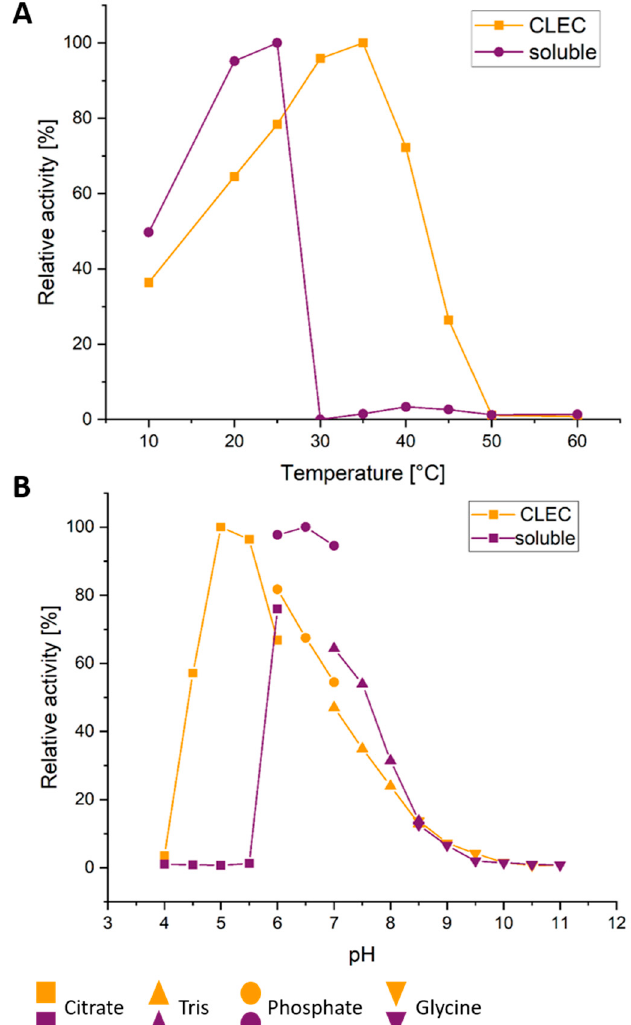
Figure 5. Temperature ( A ) and pH ( B ) profile of V46K CLECs and soluble enzyme in epoxide ring opening of 20 mM cyclohexene oxide with 40 mM azide and 100 µg biocatalyst. Reactions were performed for 2 h in duplicates, and the highest conversion was set to 100% relative activity. The 100% relative activity corresponds to 42.5% (soluble) and 44.5% (CLEC) absolute conversion for ( A ), and 65.1% (soluble) and 65.3% (CLEC) for ( B ).